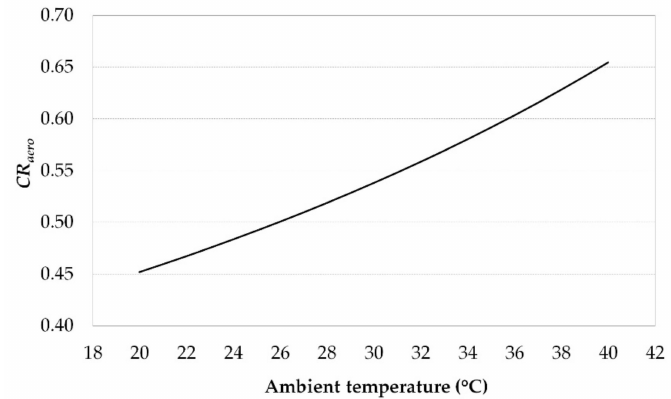
Figure 8. Value of the consumption ratio ( CR ) in the aerothermal mode for di ff erent ambient